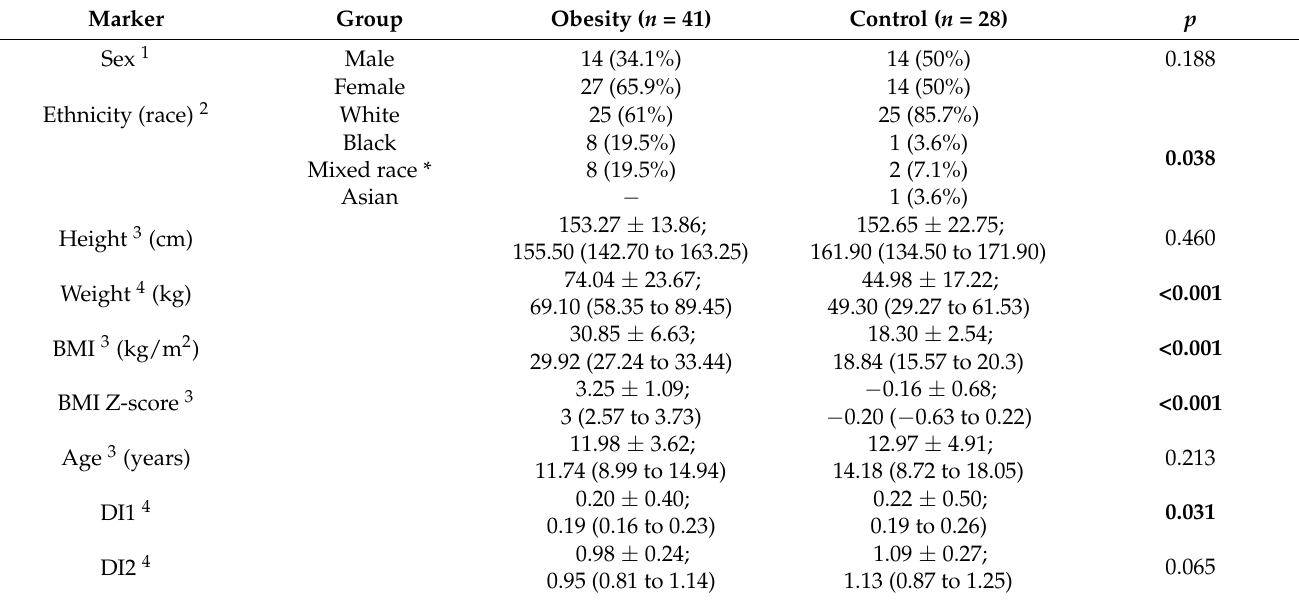
Table 1. Distribution and comparison of sex, ethnicity (race), anthropometric markers, and dysanapsis indexes between groups with and without